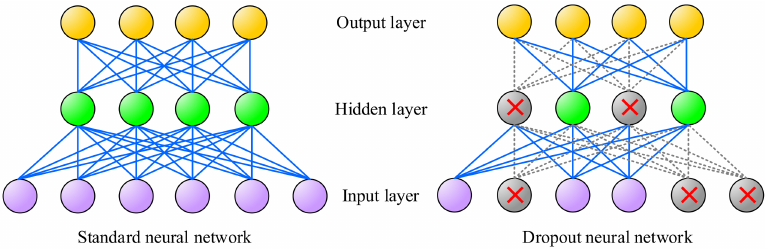
Figure 5. An illustration of standard and dropout neural networks.